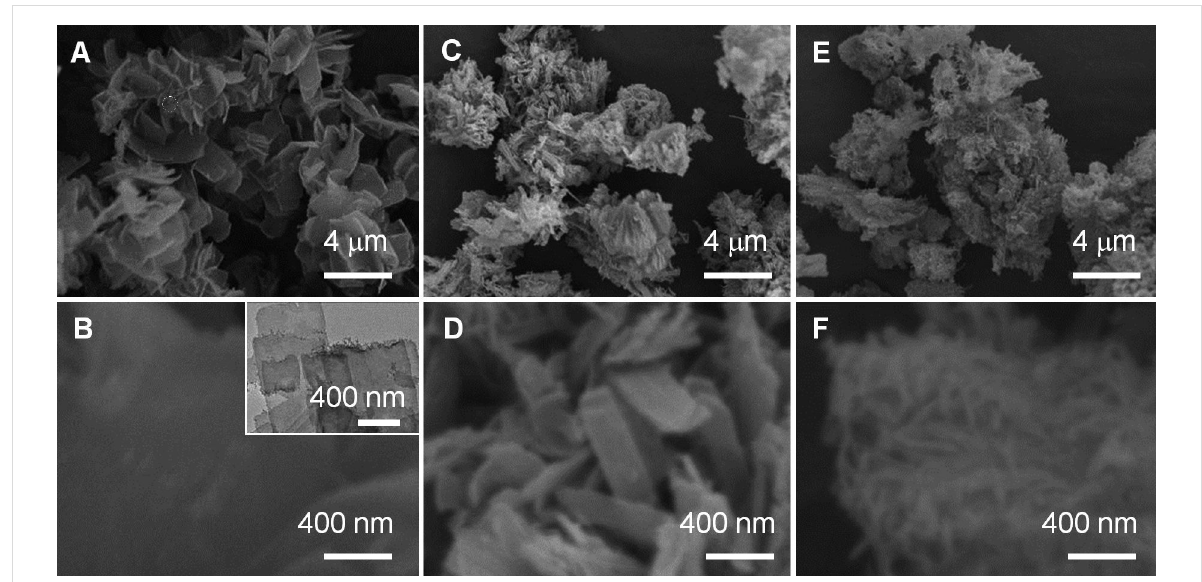
Figure 7: SEM images of silica structures, which were formed by adding different amounts of ammonia solution (NH 4 OH) to induce the crystallization- driven self-assembly of LPEI·HCl in water. The ratios of [OH]/[EI] for LPEI self-assembly are 0.6 (A and B), 0.8 (C and D) and 3.2 (E and F). The inset of B is a TEM image of the silica nanofilms. The silica deposition conditions are the same for A, B and C, which was performed by adding 1.5 mL of MS51 into 15 mL of aqueous dispersion of LPEI aggregates (pH 7.0) and stirring for 1 h at room temperature.